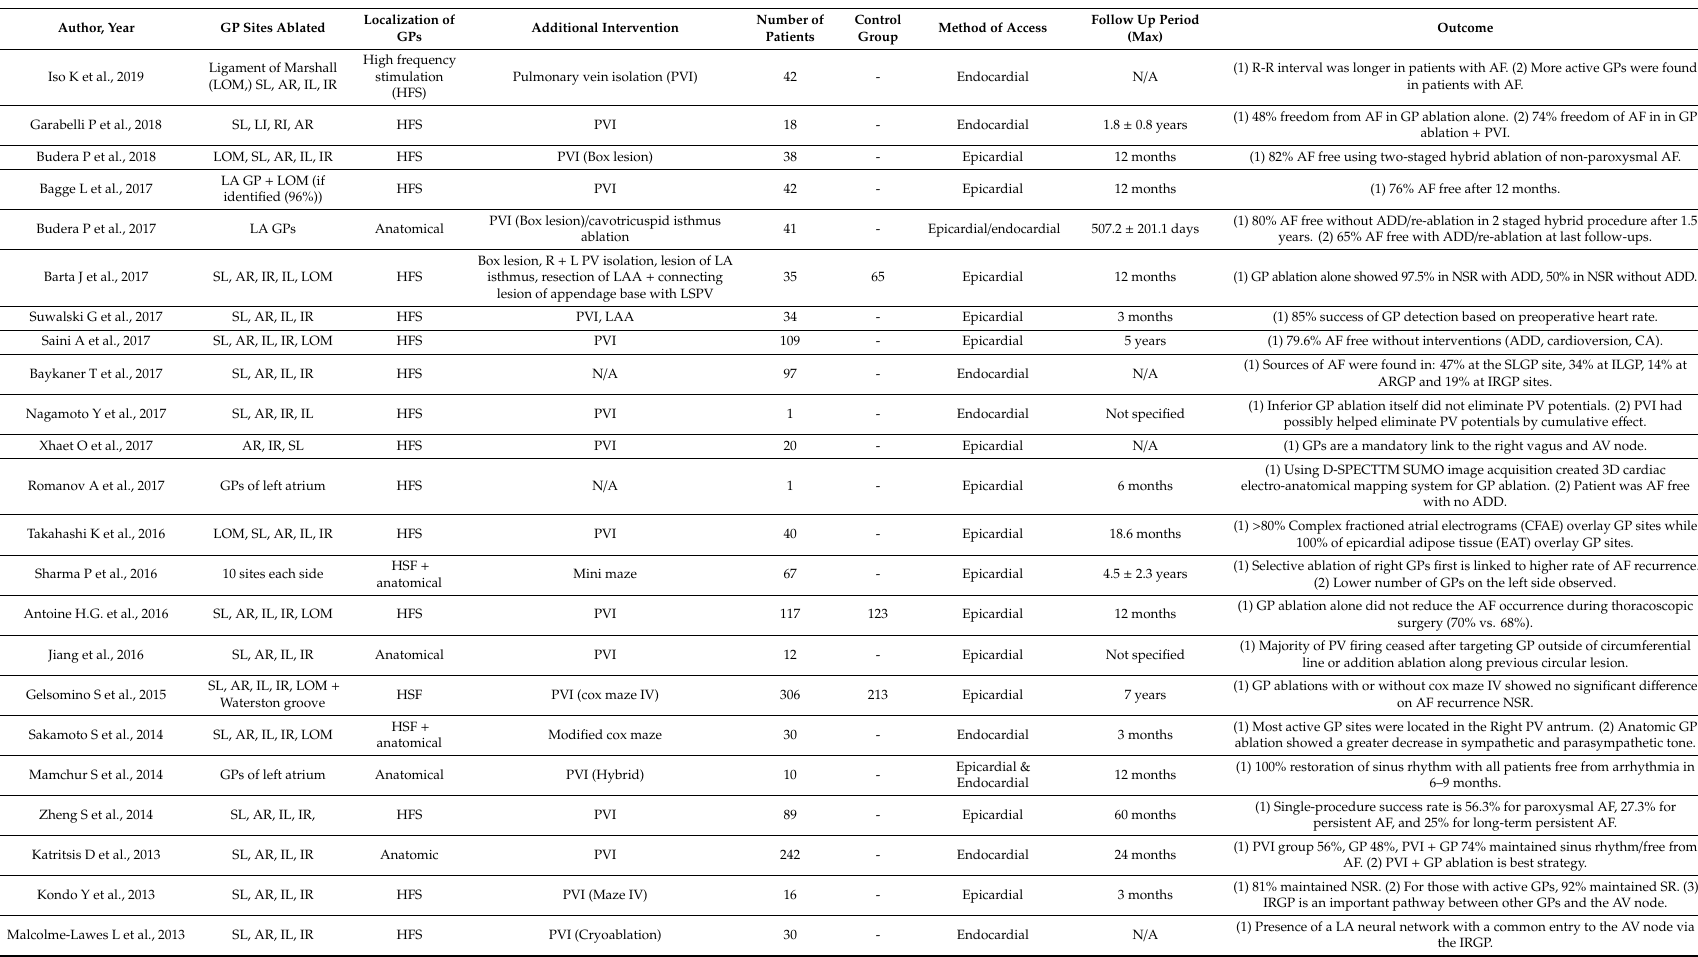
Table 1. Ganglionated plexi as main target for